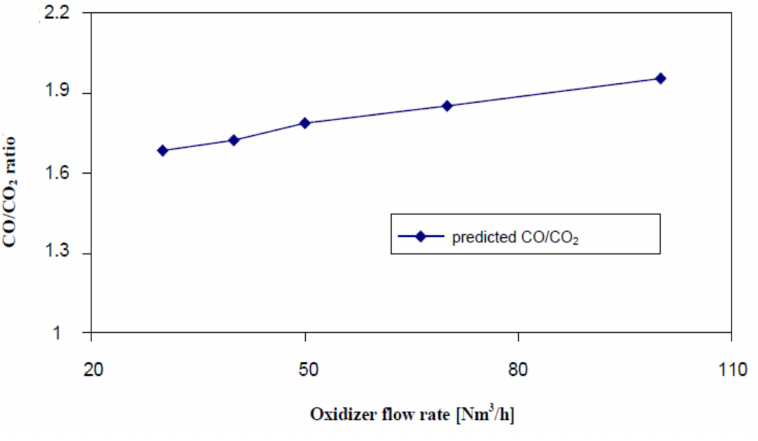
Figure 10. Influence of the amount of oxidizer on the gasification process of 20 kg pellets of 12 mm diameter at the oxidant temperature of 530 ◦ C: predicted CO/CO 2